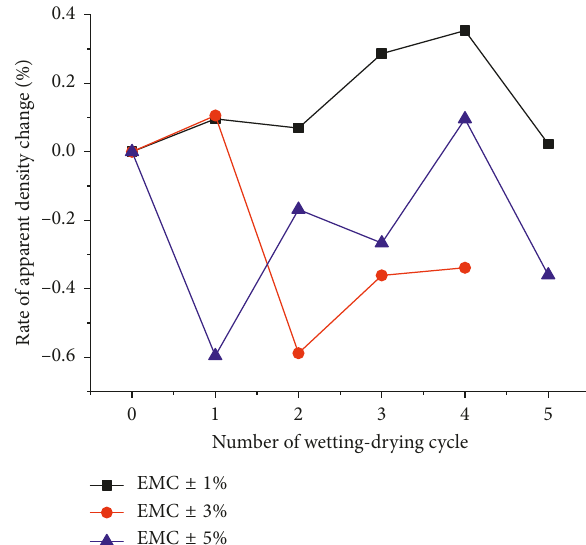
Figure 16: Variations of rate of apparent density change with wetting-drying cycles.